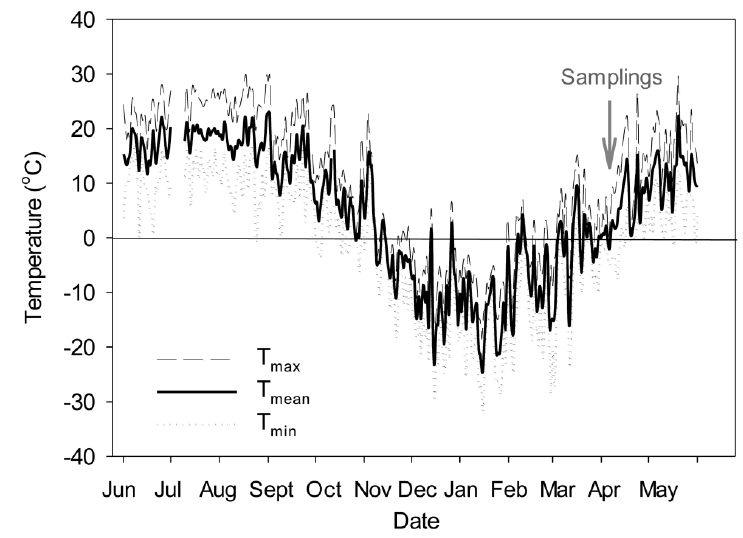
Figure 1. Maximum, minimum and mean air temperatures measured daily at the Aspen FACE site from June 2008 to May 2009. The date of the sampling is shown by the arrow (April 4, 2009).